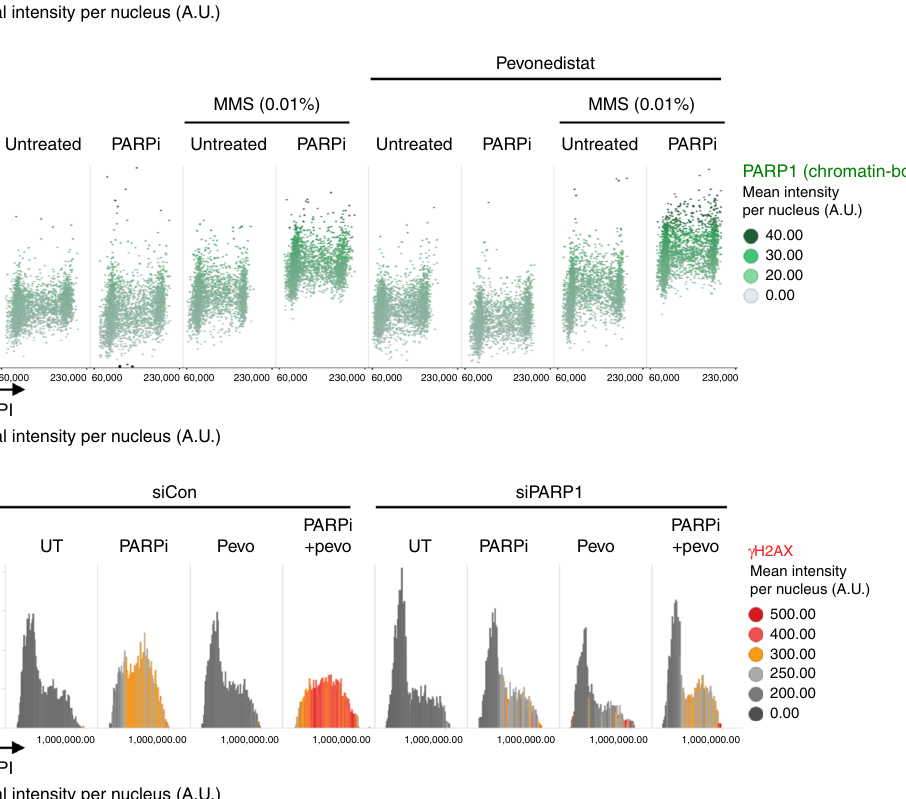
Fig. 7 A functional interaction between inhibition of NEDD8/SCF and PARPi. a Overview of the siRNA screening procedure. For each well, EdU incorporation, DNA content and γ H2AX signaling was quanti fi ed at the single cell level. b z -score according to γ H2AX in S-phase cells. c Cell cycle resolved γ H2AX pro fi les obtained from the screen for cells transfected with 3 siRNAs for CUL1 are shown. d U-2 OS cells were treated with 1 μ M olaparib and 10 nM pevonedistat (pevo), and cell proliferation was evaluated by clonogenic survival. Data are presented as mean ± s.d. ( n = 3). P -values were obtained by unpaired t -test. e U-2 OS cells were treated with 10 μ M olaparib and 0.01% MMS for 4 h in the presence or absence of pevonedistat (100 nM, added 4 h prior to and kept on during the PARPi/MMS treatment), pre-extracted on ice in 0.2% Triton X-100 for 2 min to remove soluble, non-chromatin-bound proteins, and stained for PARP1 and DNA content. Chromatin-bound PARP1 levels were quanti fi ed and are depicted as a function of cell cycle progression. f U-2 OS cells were transfected with siRNA against PARP1, treated with 10 μ M olaparib and 100 nM pevonedistat for 24 h, and stained for γ H2AX and DNA content. Cell cycle pro fi les are shown. Color codes as de fi ned in the fi gure